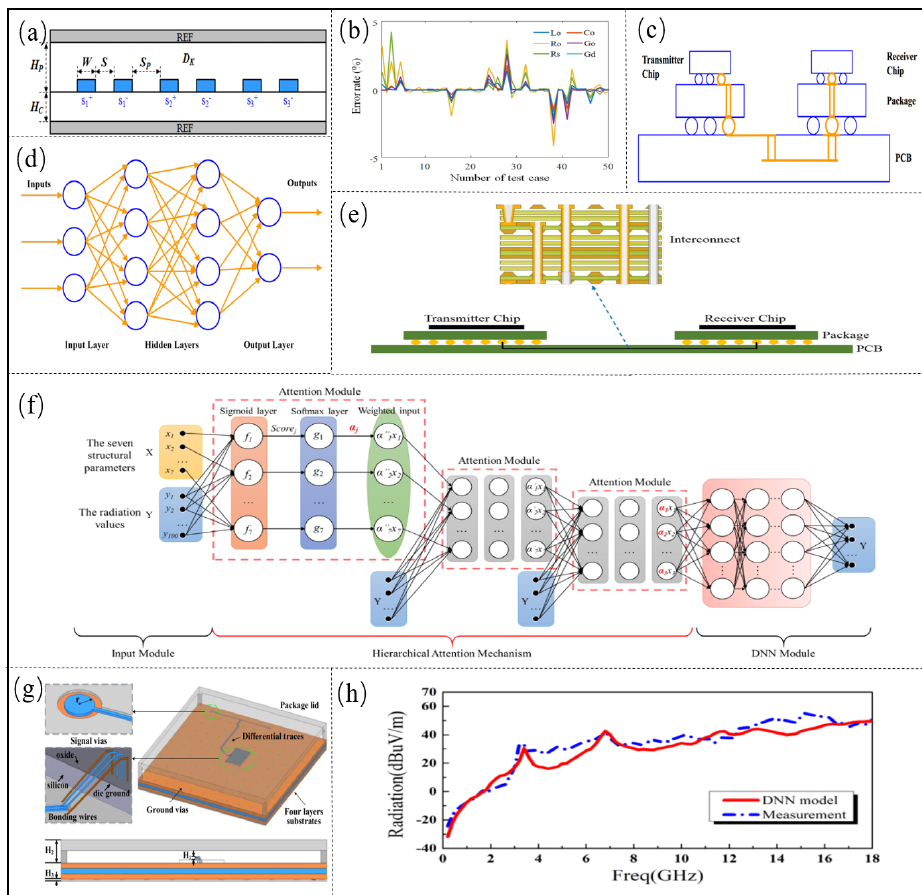
Figure 4. ( a ) Target channel for modeling. Adapted with permission from [59]. ( b ) Validation of predicted channel RLGC by ANN model. Adapted with permission from [59]. ( c ) The topology of a high-speed channel. Adapted with permission from [29]. ( d ) Model of high-speed channel established by DNN. Adapted with permission from [29]. ( e ) Cross-section view of the high-speed channel. Adapted with permission from [31]. ( f ) Hierarchical attention-based DNN. Adapted with permission from [68]. ( g ) WB-BGA package model. Adapted with permission from [68]. ( h ) Comparison of EMI radiation results predicted by DNN model and results measured by far-field experiment. Adapted with permission from